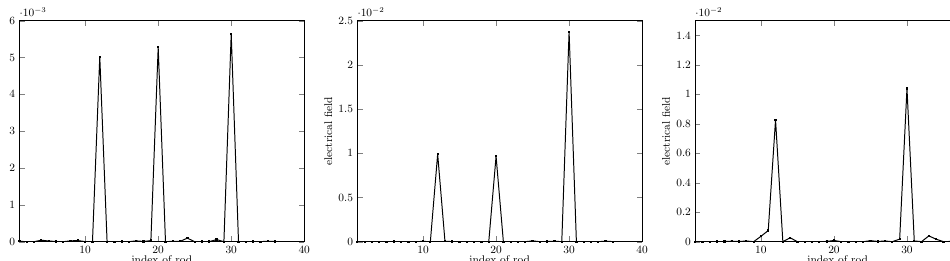
Figure 7. Retrieval for different spacings d , from left to right, d = λ /2, λ /4, λ /6. The rods’ radius R remains λ /12. Missing rods (not shown) are of indexes 12, 20, and 30.